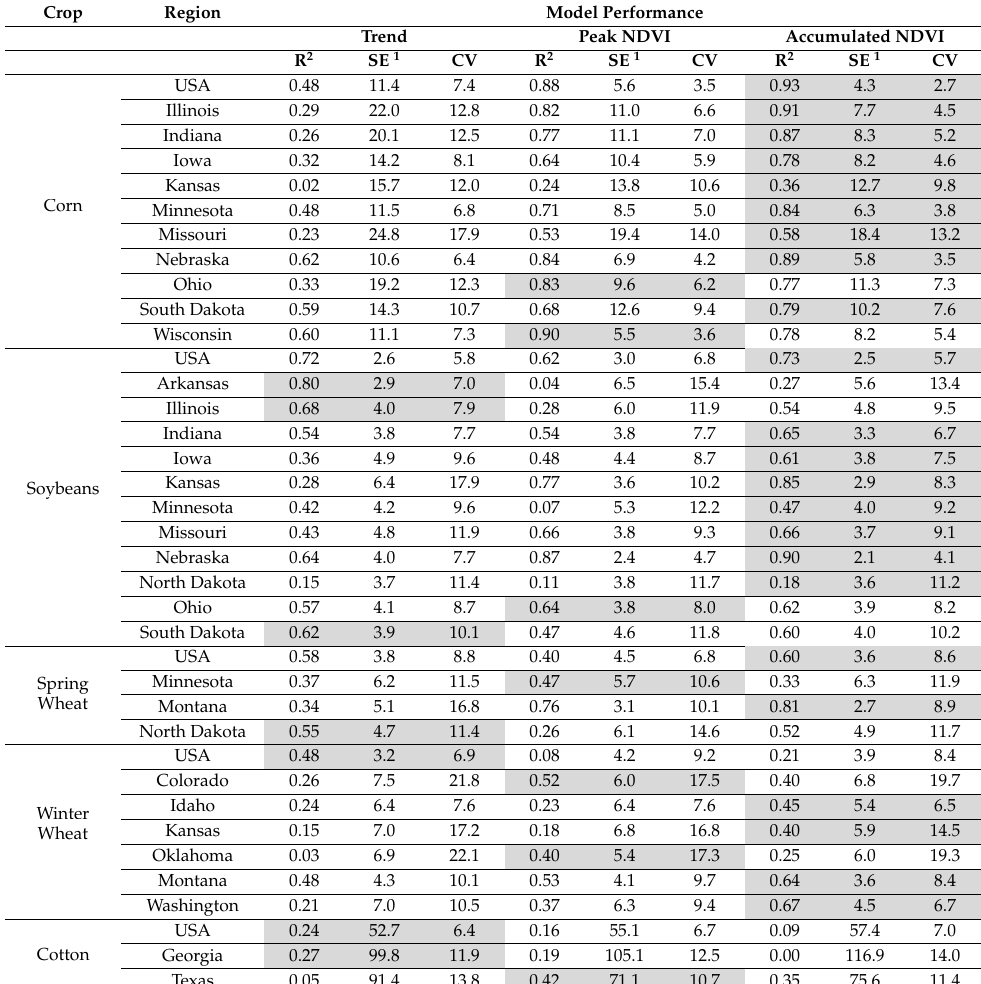
Table 1. Model performance results expressed as the correlation coefficient (R 2 ), standard error (SE), and coefficient of variation (CV). Highlighted grey is the best performance of the three scenarios by crop and